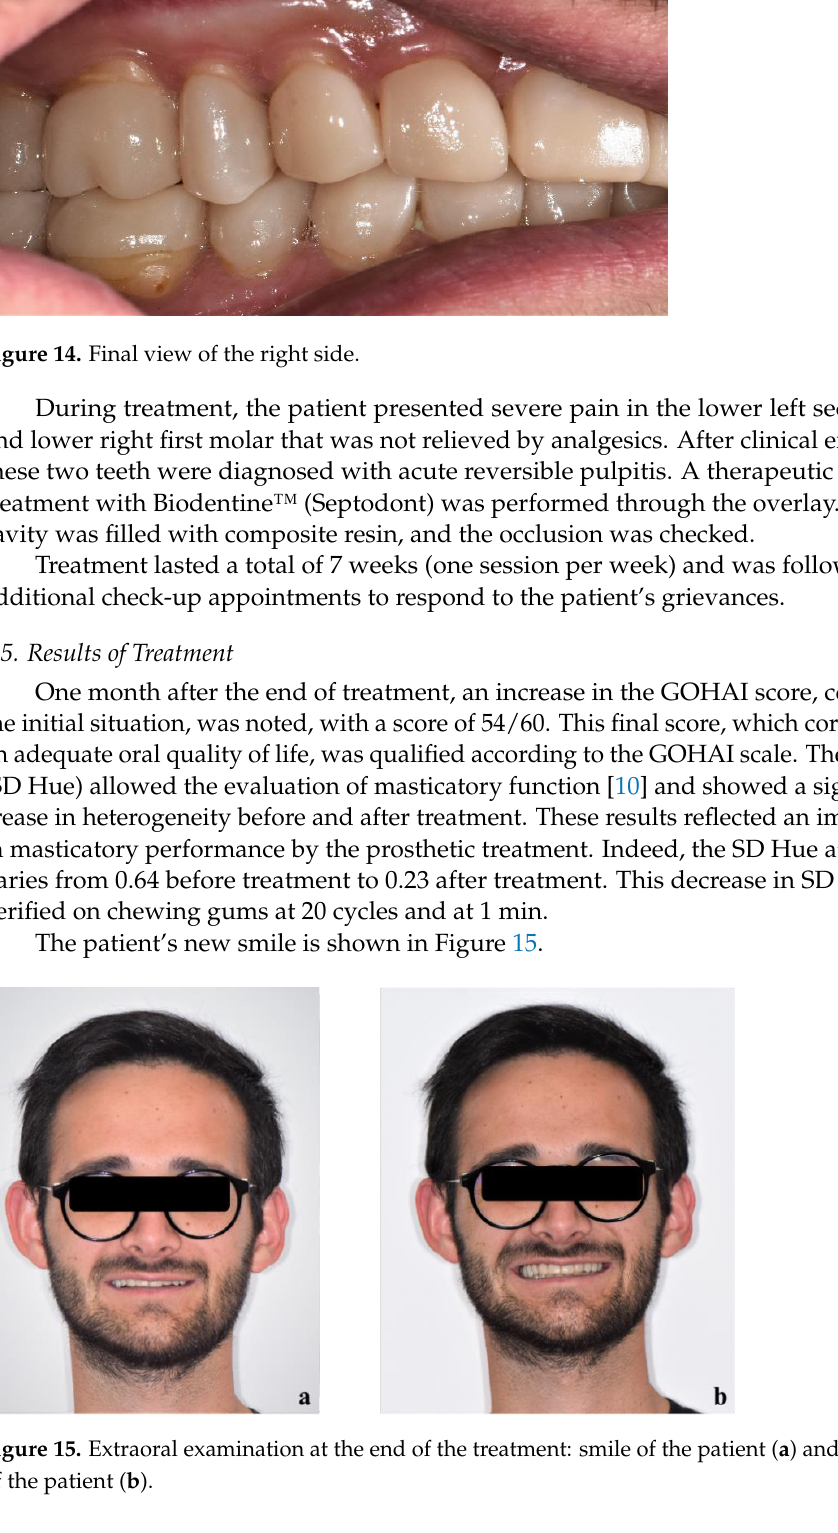
of the patient ( b of the patient ( b ).